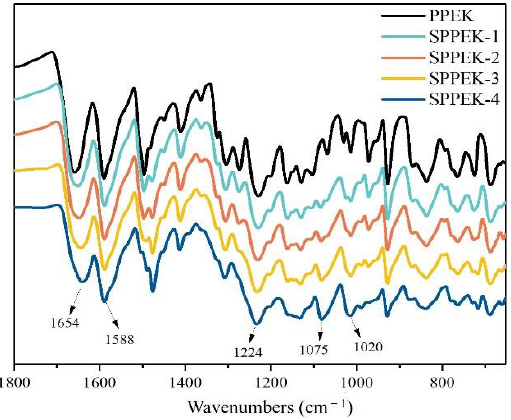
Figure 5. FT-IR spectra of PPEK and SPPEK.